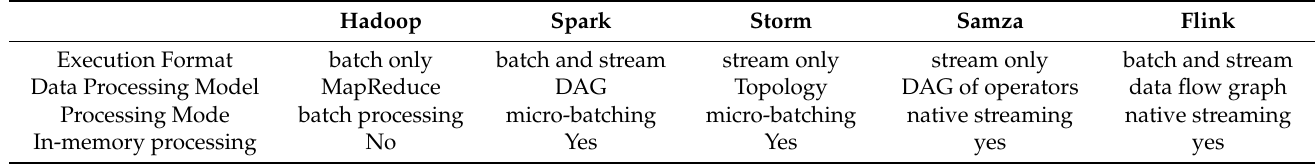
Table 5. Comparison of big data frameworks with respect to feature vector related to data processing. Hadoop Spark Storm